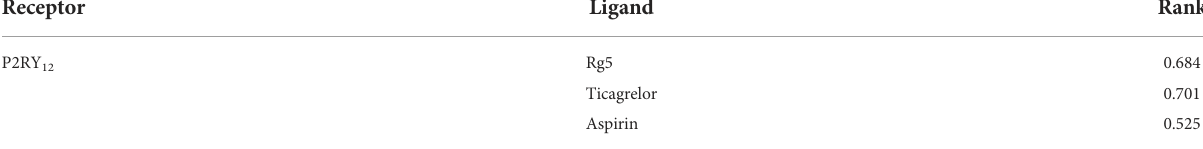
TABLE 1 Ranking results of Rg5, Ticagrelor, and Aspirin binding to P2RY 12 .